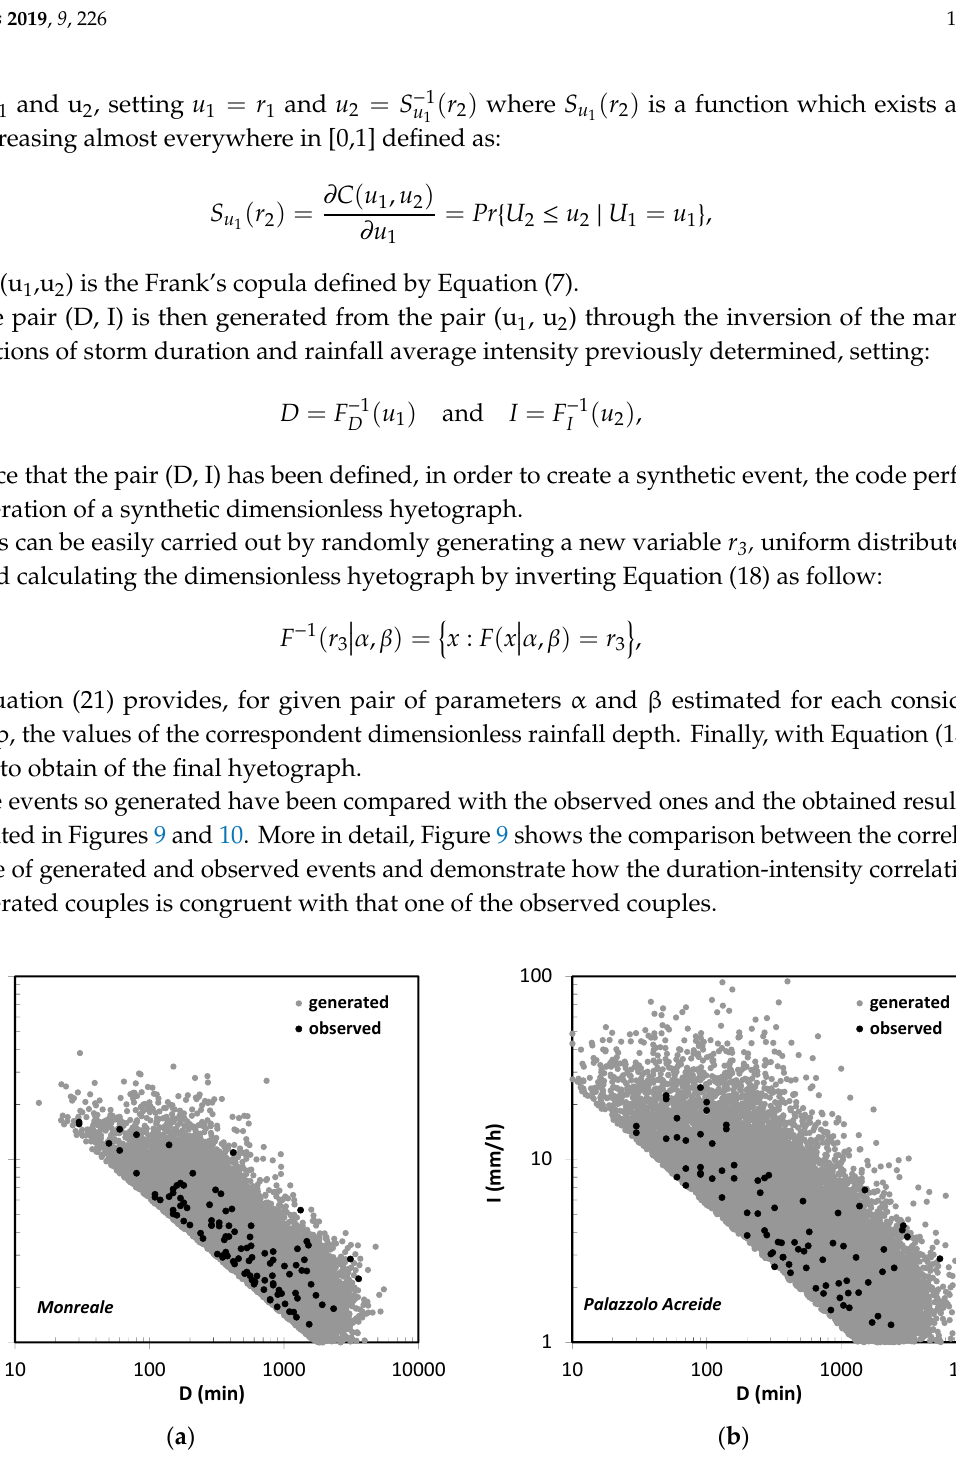
( f ) Figure 10. Comparison between observed and generated hyetograph shape: ( a ) mean at the Monreale rain gauge station; ( b ) standard deviation at the Monreale rain gauge station; ( c ) 10 th , 50 th and 90 th at the Monreale rain gauge station; ( d ) mean at the Palazzolo Acreide rain gauge station; ( e ) standard deviation at the Palazzolo Acreide rain gauge station; ( f ) 10 th , 50 th and 90 th at the Palazzolo Acreide rain gauge station.